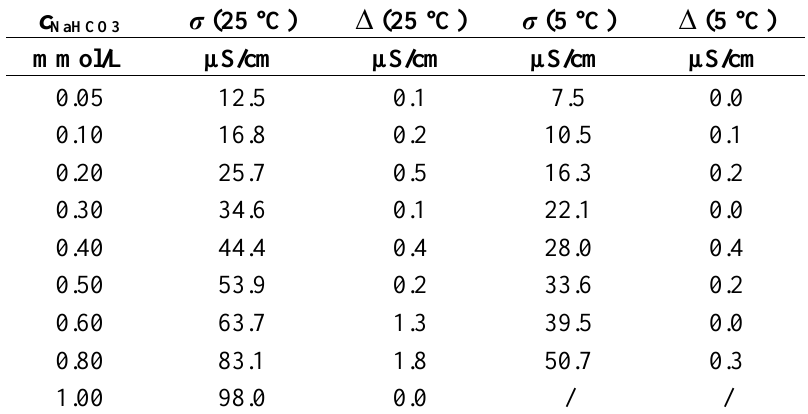
Table 5. Equations of conductivity curves (CC) with deviations from linearity ( R 2 ); conductivity of one-day-old NaHCO solutions measured at 25 and 5 °C in 2.5 mL flasks. 3 Conductivities, σ , are in µS/cm, concentrations, c , in mmol/L. CC NaHCO3